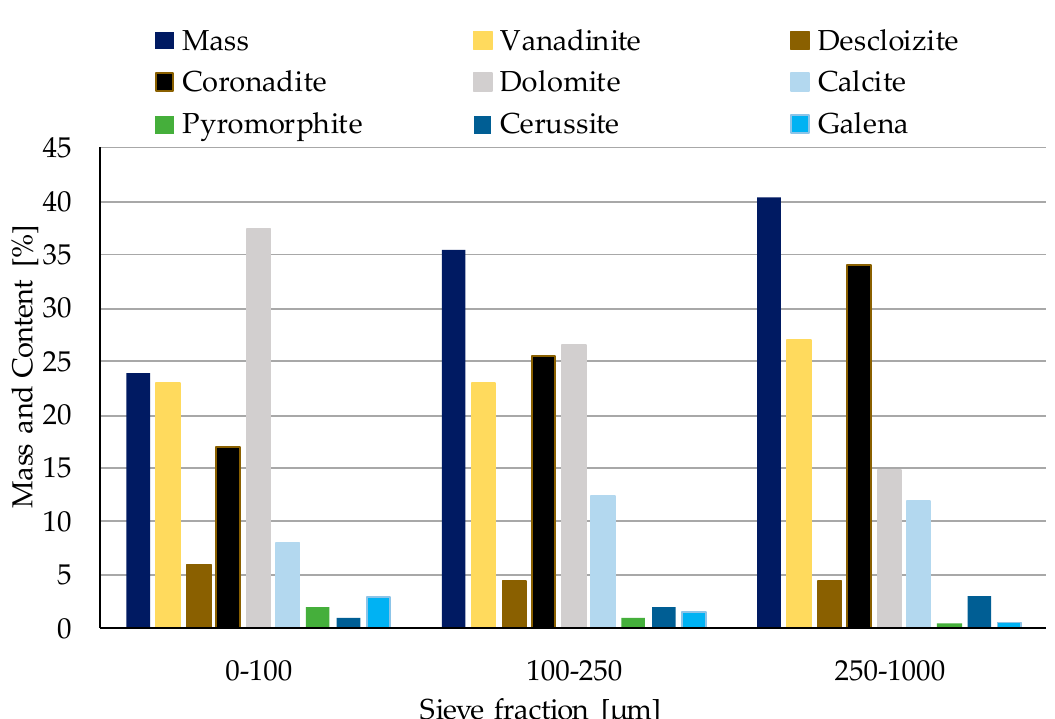
Figure 8. Modal mineralogy of first concentrate in sieve fractions based on MLA.